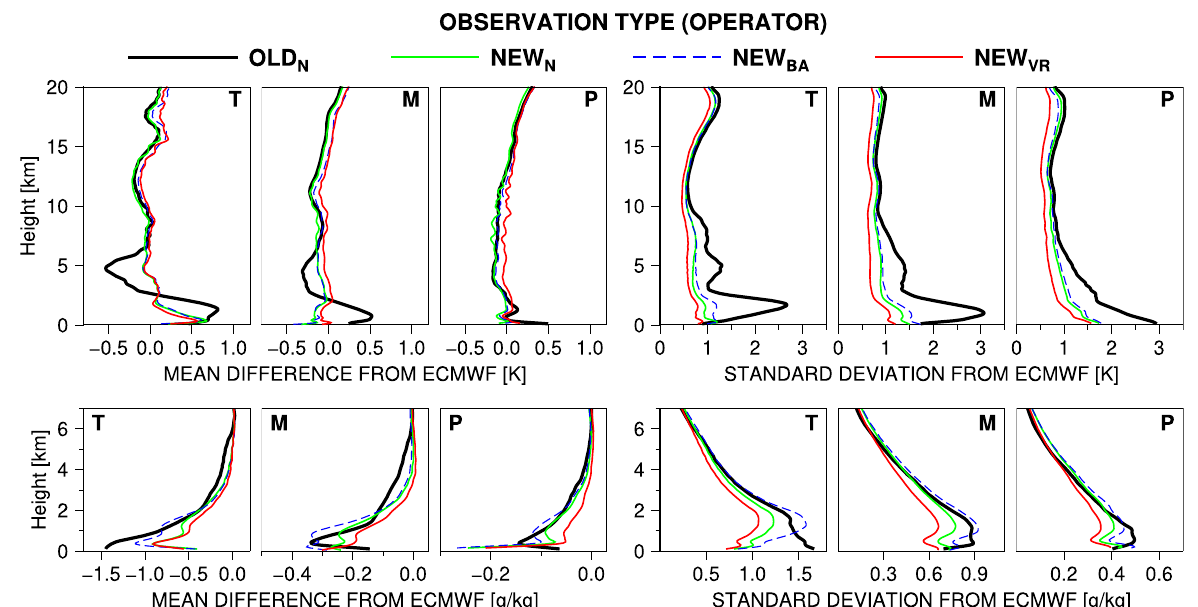
Figure 10. Comparison of 1DVAR observation operators, for which 1DVAR temperatures ( upper panels ; °C) and specific humidities ( lower ; g kg −1 ) produced with different observation operators are compared to ECMWF analysis in the tropics (0–30°; denoted as T at the top right corner of each panel), middle latitudes (30–60°; M), and polar latitudes (60–90°; H). Left panels show differences in the mean and right panels present the standard deviations. See text for the description of the observation operators.